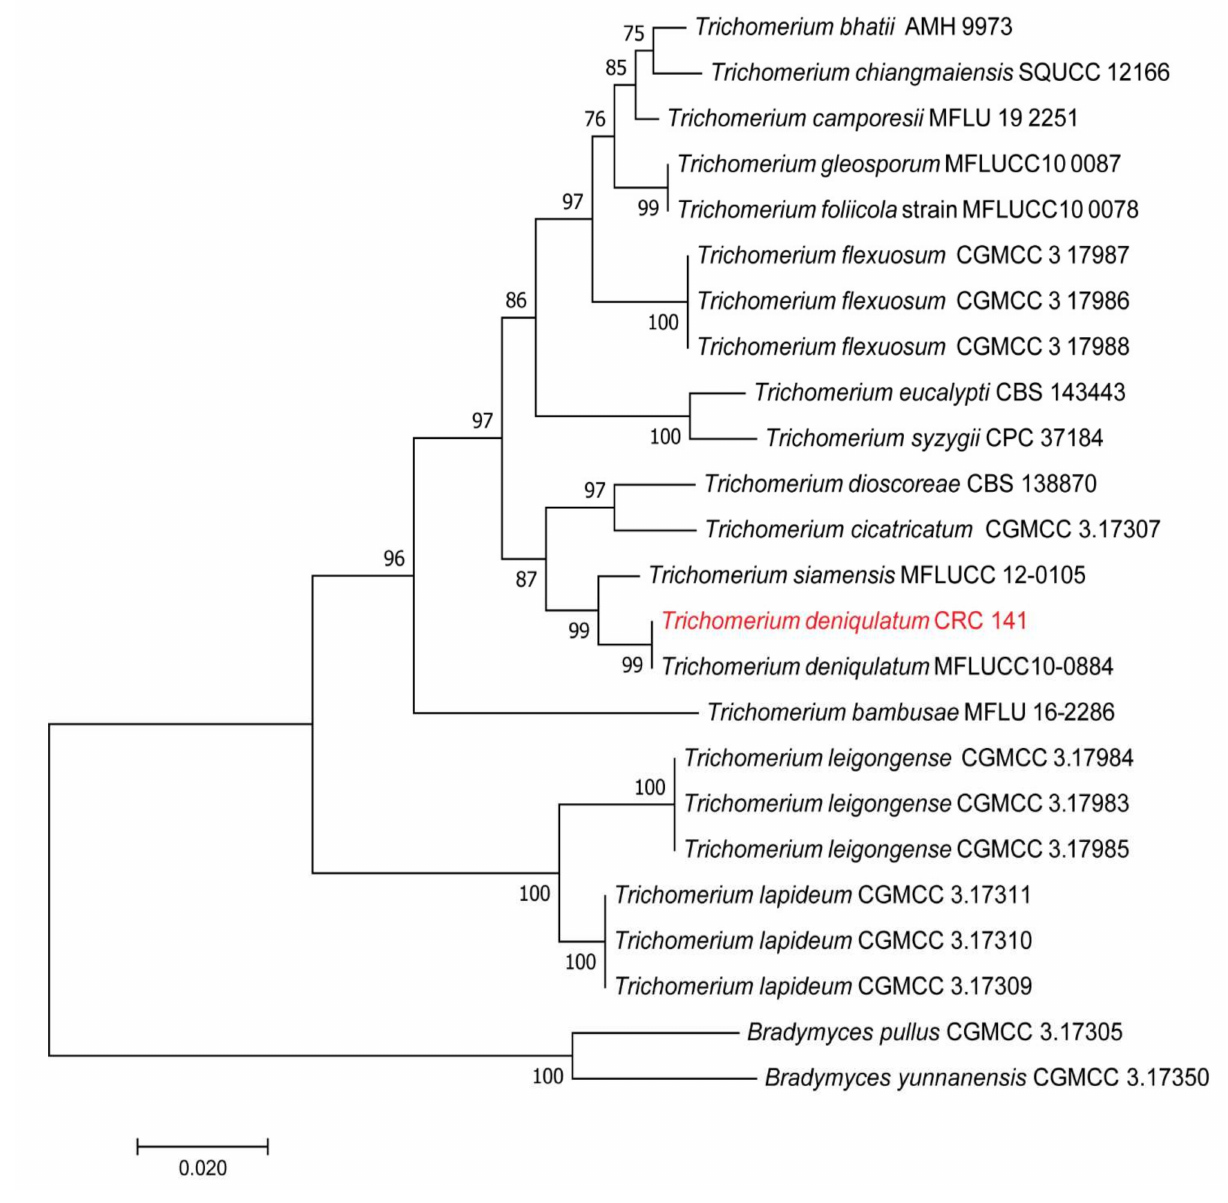
Figure 2. Neighbor-joining phylogenetic tree of Trichomeriaceae generated based on the combined LSU and ITS. Bootstrap support values for neighbor-joining phylogeny equal to or higher than 75% are displayed on the nodes. The newly generated strain in this study is indicated in red. The tree is rooted to Bradymyces pullus (CGMCC 3.17305) and B. yunnanensis (CGMCC